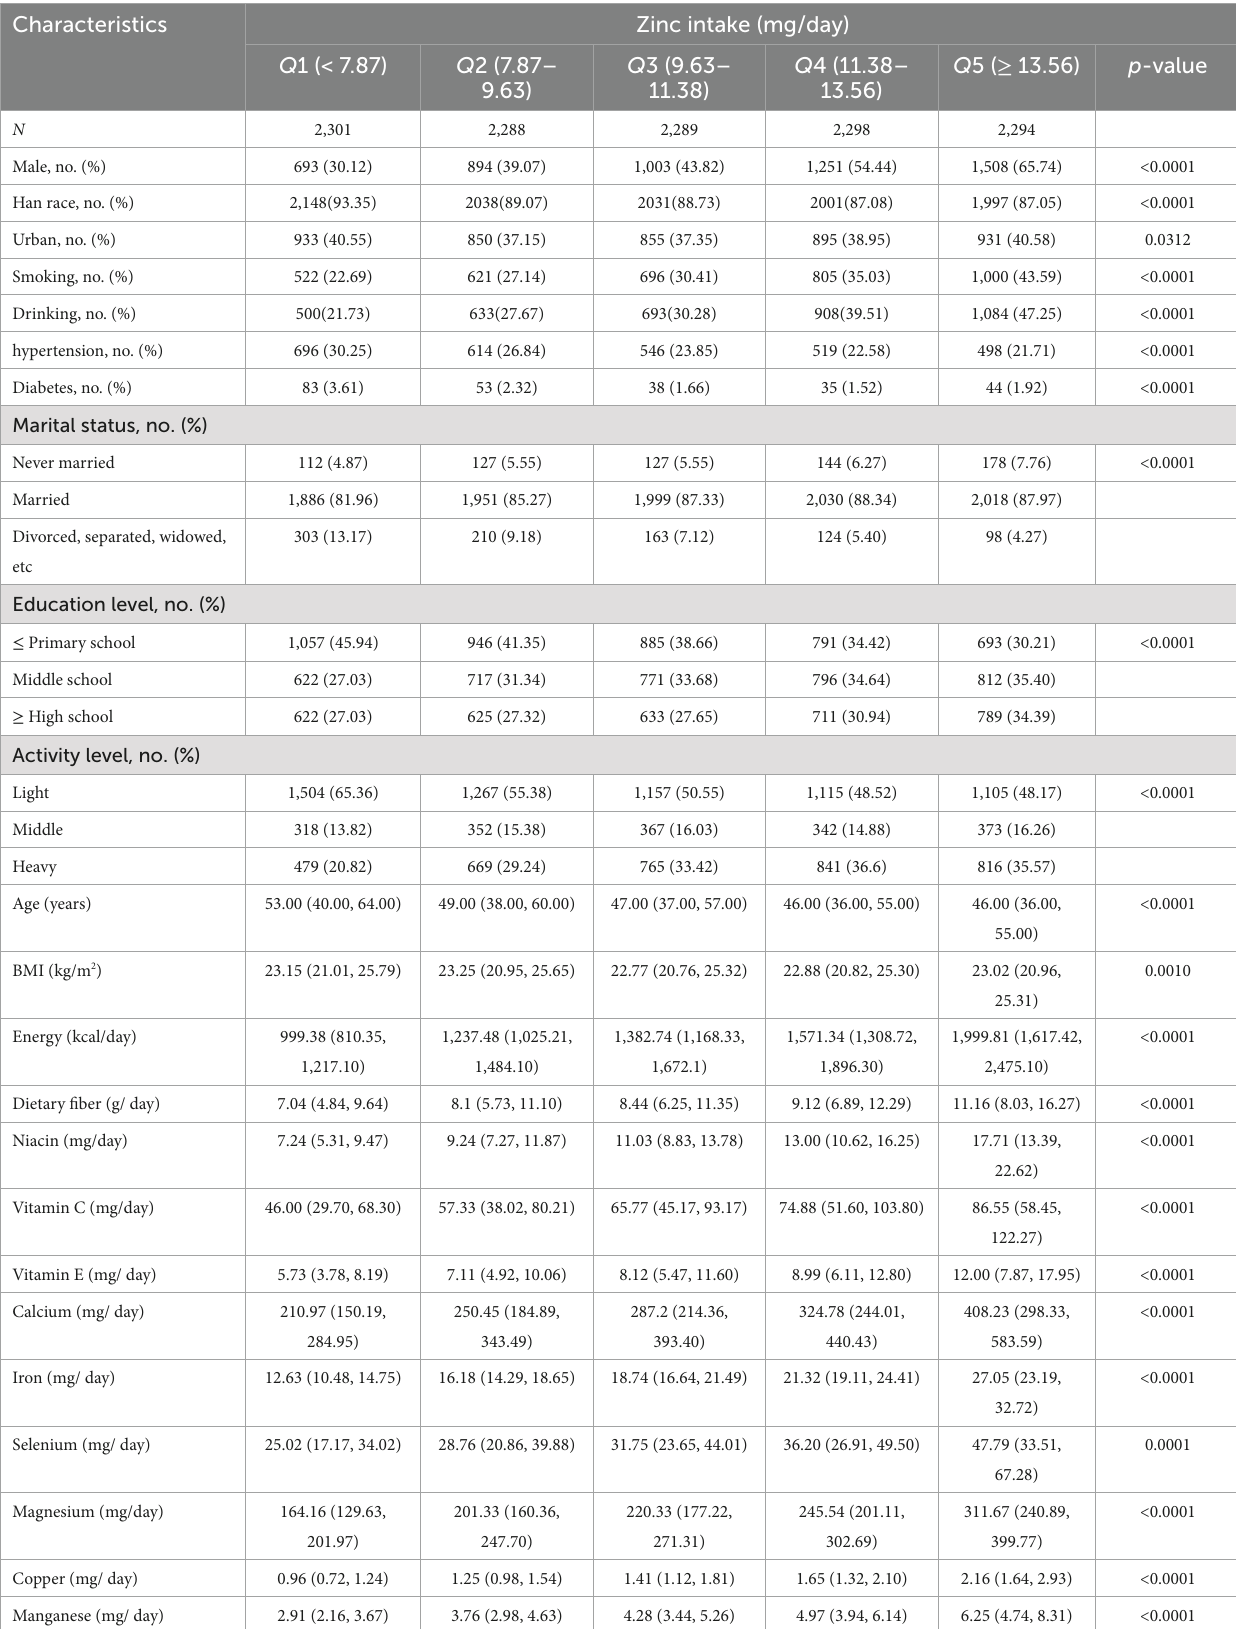
TABLE 2 Baseline characteristics of participants according to quintiles of dietary zinc intake.